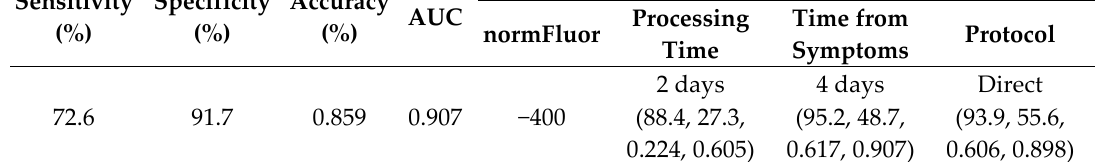
Figure 7. Recalculated ROC curve using all cut ‐ off points found for experimental and time variables. The numbers in parentheses correspond to (Sensitivity, Specificity, Youden index, AUC). Red line: ROC curve, Black line: non ‐ discrimination line.